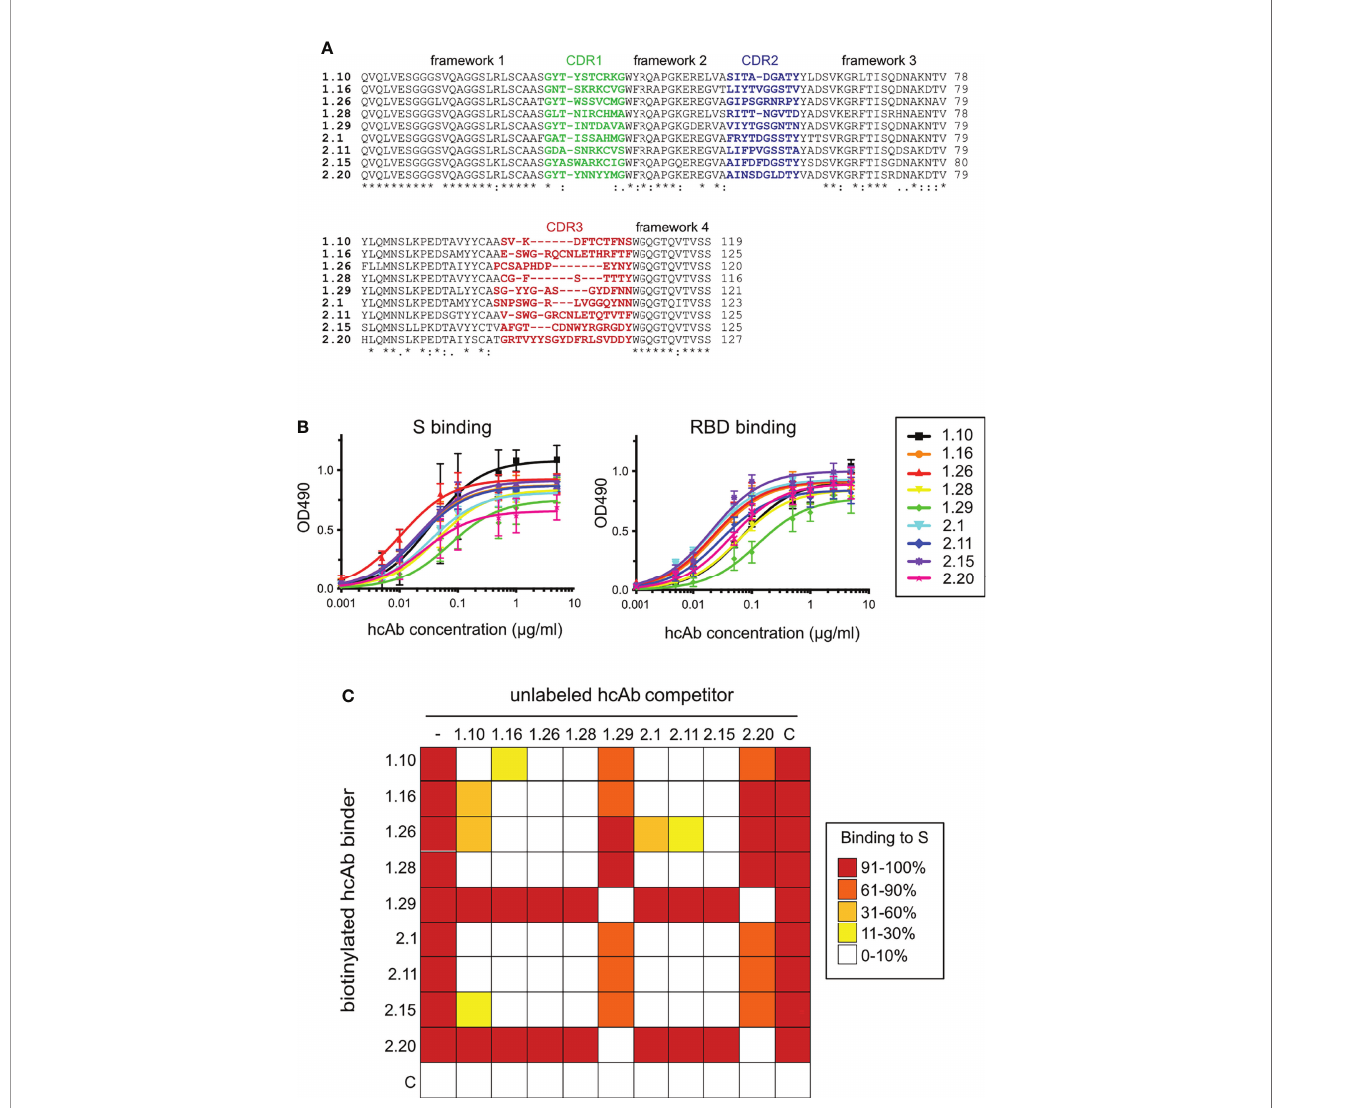
FIGURE 1 | SARS-CoV-2 RBD-speci fi c Nbs, binding to S and RBD proteins, and cross-competition analysis. (A) Sequence alignment of the 1.10, 1.16, 1.26, 1.28, 2.1, 2.11, 2.15 and 2.20 Nbs selected from bacterial libraries that displayed VHH domains isolated from two immunized dromedaries with the SARS-CoV-2 RBD ( Figure S1 ). Their VHH frameworks and complementarity determining regions (CDRs) 1 to 3 are indicated. Alignment generated with Clustal Omega (55). Labels indicate full conservation (*) or degree of conservation (: or .). (B) Binding of Nb-derived hcAbs to the S (left) or RBD (right). The hcAbs contained the RBD-speci fi c Nb domains fused to the human IgG1 hinge and Fc portion ( Figure S2A ). Binding of serial hcAb dilutions to plastic-bound proteins measured as Optical Density at 490 nm (OD 490 ) as described in Materials and methods . Average and standard deviations (n ≥ 3). (C) S binding competition among hcAbs. Heatmap representation of the binding data shown in Figure S3 , and determined with biotin labeled hcAbs (left) without (-) or with the unlabeled hcAb competitor shown on the top. A control hcAb (C) was also included. Mean of three independent experiments (n =